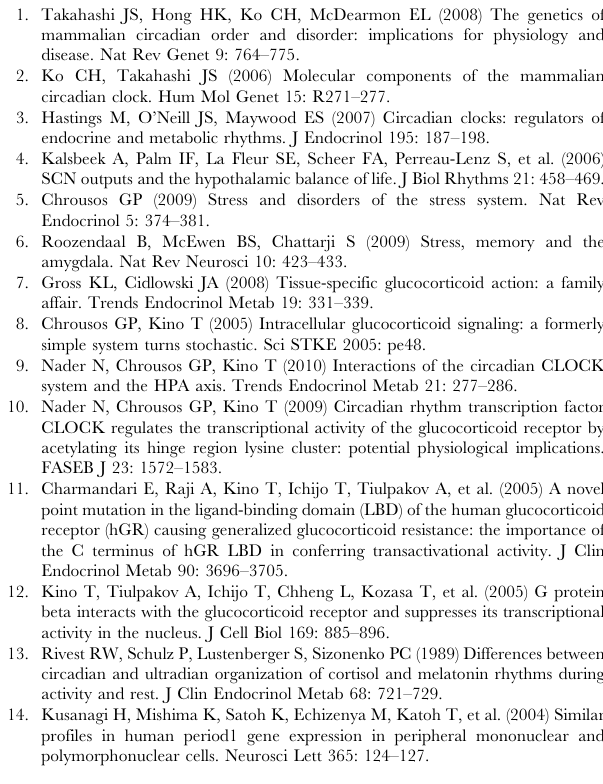
in the presence of hydrocortisone (n= 6, m= 12). (TIF) Figure S3 Knockdown of Clock mRNA abolishes diurnal fluctuation of annexin A1 mRNA expression in PBMCs cultured ex vivo . PBMCs obtained at 6 am from 3 healthy subjects were transfected with Clock or control siRNA and were treated with 5 6 10 2 7 M of hydrocortisone (HC) for 3 hours at every 6 hours. mRNA expression of annexin A1 was determined. Experiments were performed with duplicate for each subject. Circles represent the mean 6 S.E. values of fold mRNA expression of the indicated genes obtained in the absence and presence of hydrocortisone (HC). The values obtained in the absence of hydrocortisone (HC) were employed as controls. **: P , 0.01, n.s.: not significant, compared to the values obtained in the presence of hydrocortisone (HC) at time ‘‘0’’ for mRNA expression of glucocorticoid- responsive genes (n= 3, m= 6).